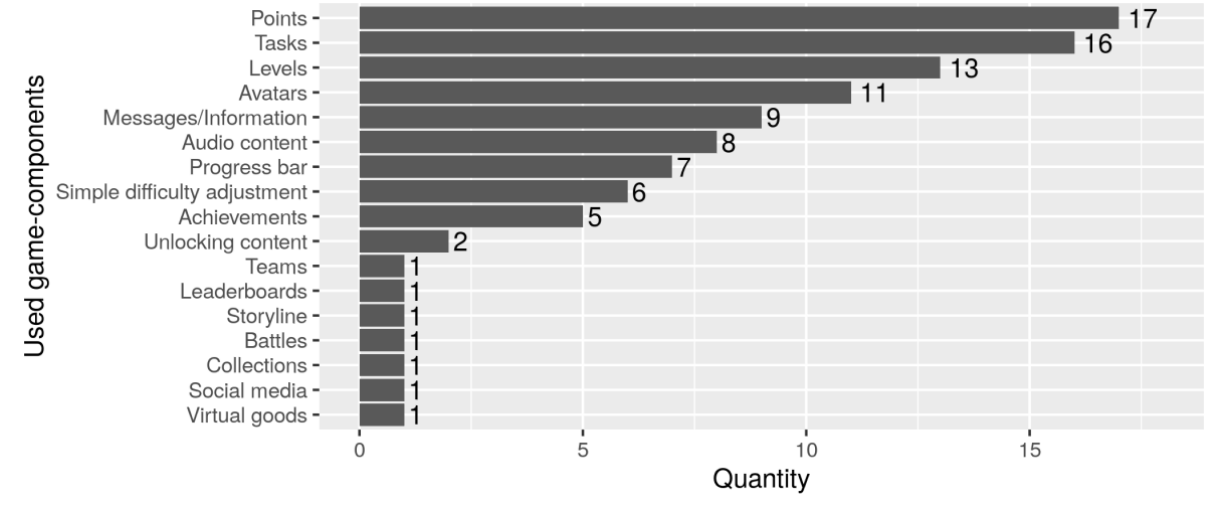
Figure 3. Overview of game components ordered by frequency.